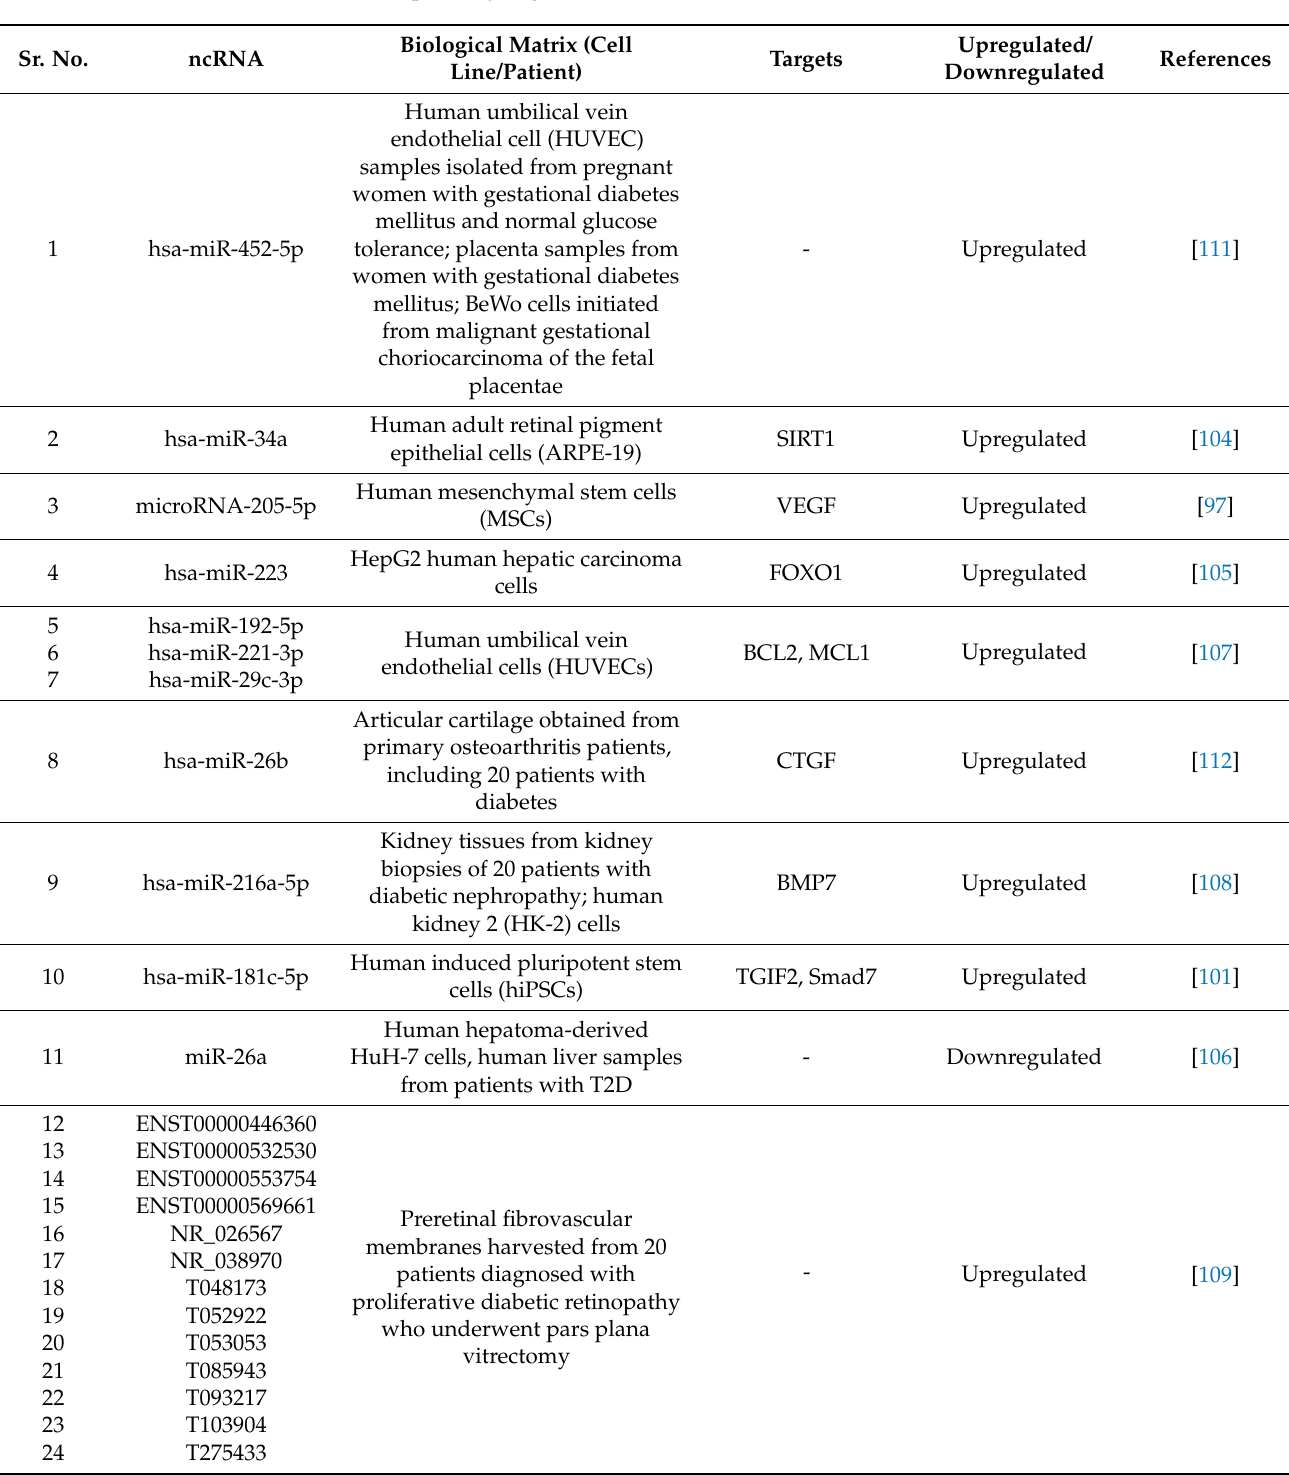
Table 5. Spatial dysregulation of ncRNAs in